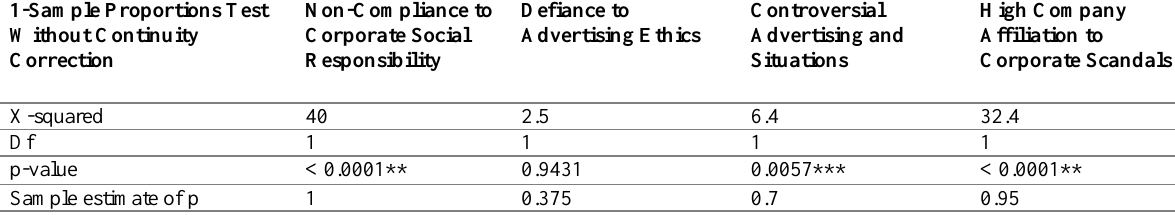
Table 3: One Sample Proportion